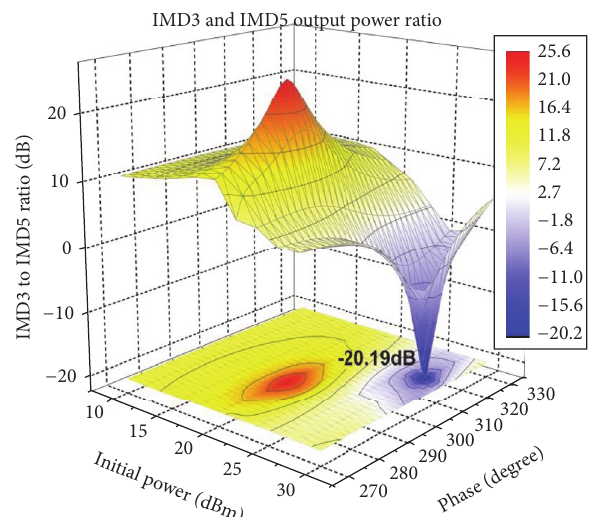
according to the phase and to IM 5